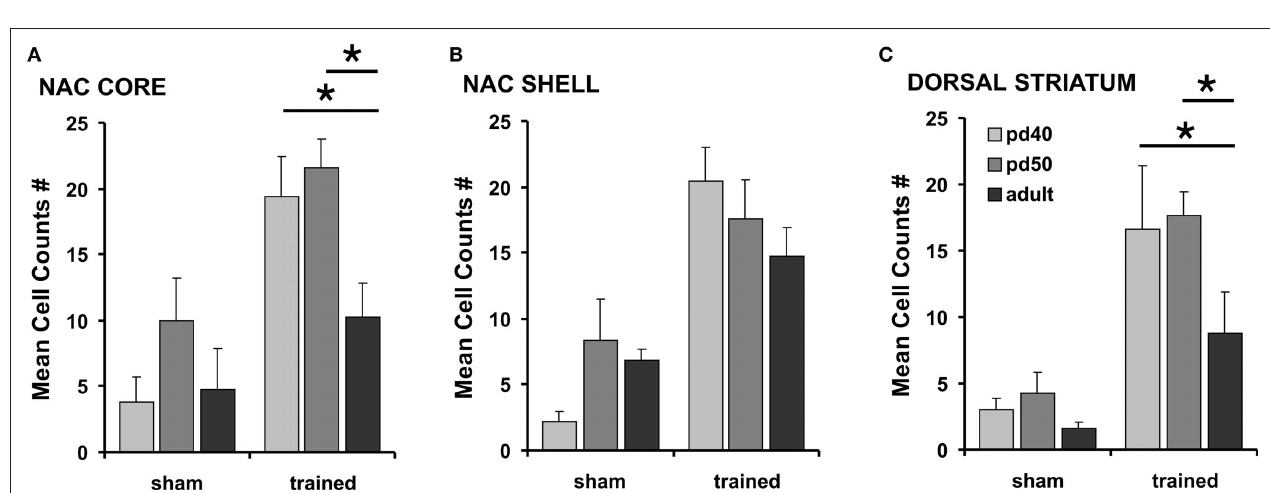
Figure 3 | Progressive ratio performance of early- (pd 40), mid-pubertal (pd 50) and adult rats (pd 90). The figure depicts total lever presses (A) , HCR (B) and the break point (IR) (C) . Performance of mid-pubertal rats differed